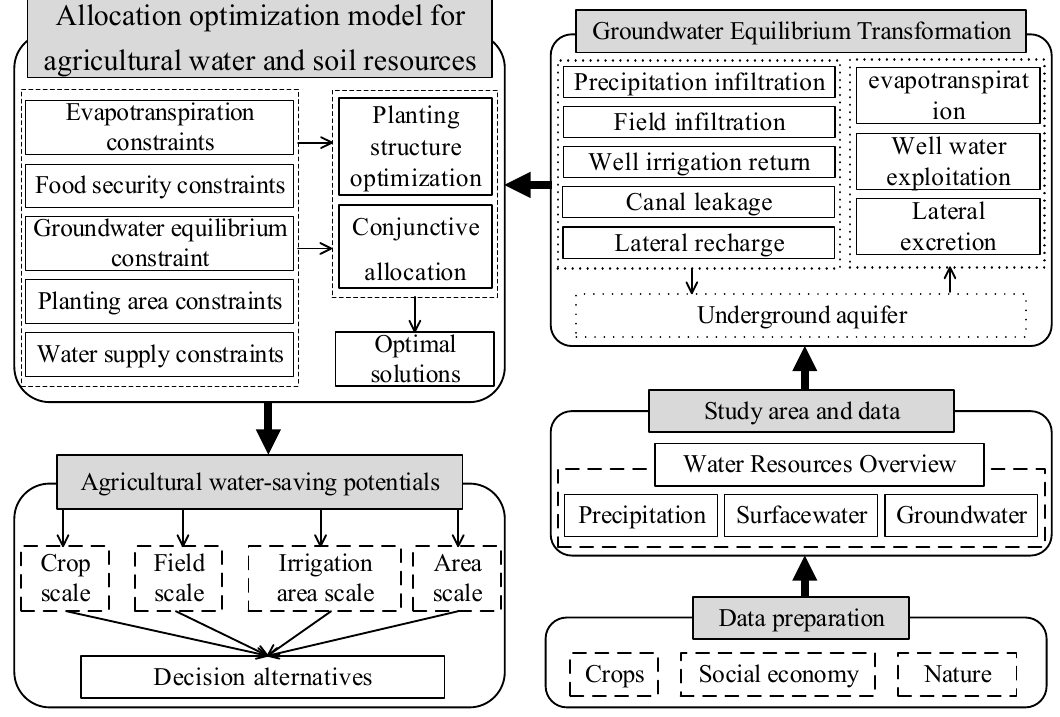
Figure 6. System framework.